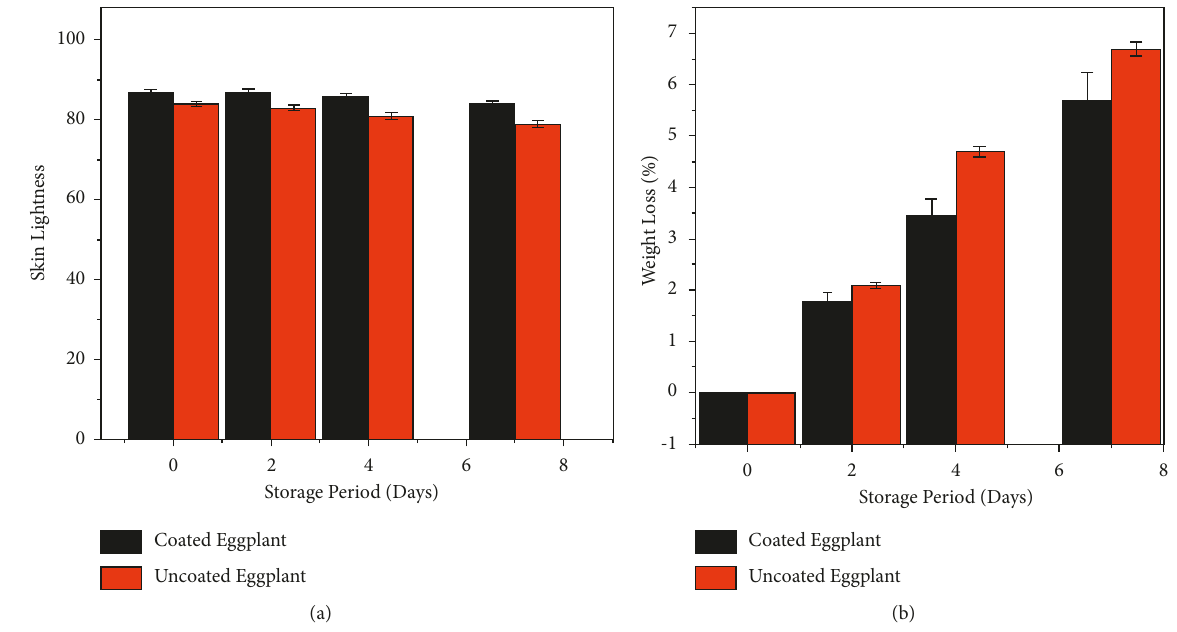
Figure 3: Effect of active coating on the skin lightness (a) and weight loss of (b) solanum melongena during storage